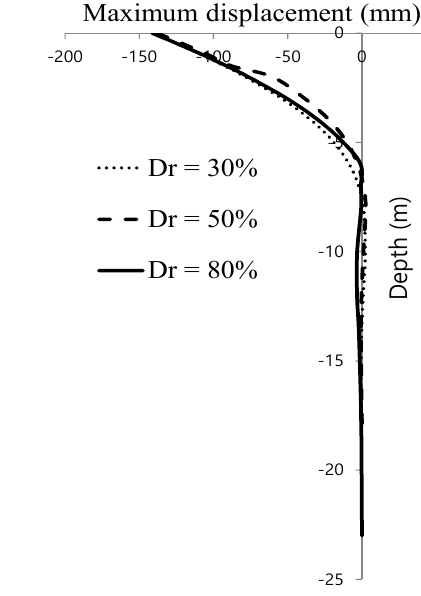
Figure 15. Peak bending moment envelopes obtained from three different relative densities. ( a ) Input acceleration: 0.13 g; ( b ) Input acceleration: 0.25 g.